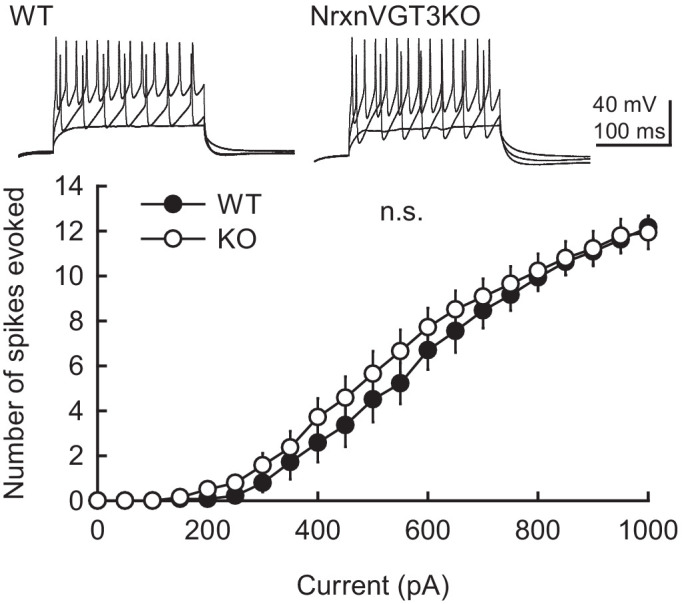
Membrane excitability is not altered in VGT3+ interneurons in NrxnTKO/VGT3/RFP mice.(Top) Sample traces of VGT3+ interneurons in organotypic hippocampal slice cultures prepared from VGT/RFP (wild-type [WT], left) and NrxnTKO/VGT3/RFP (knockout [KO], right) mice. The superimposed traces were elicited by current injections of 200, 500, and 900 pA for 200 ms. (Bottom) Summary graph of the frequency of action potentials in WT and KO VGT3+ interneurons. The input–output relationship (number of spikes elicited vs. amount of current injection over a 200 ms duration) was plotted for WT and KO neurons. Neurons were held at resting membrane potentials. Two-way ANOVA with Sidak’s post hoc test: number of cells tested: untrans, 14 cells from five mice (14/5); trans, (14/5). n.s., not significant. Resting membrane potentials were not significant between WT and KO VGT3+ interneurons: WT, −56.3 ± 0.46; KO, −56.0 ± 0.28 mV (Student’s t-test).